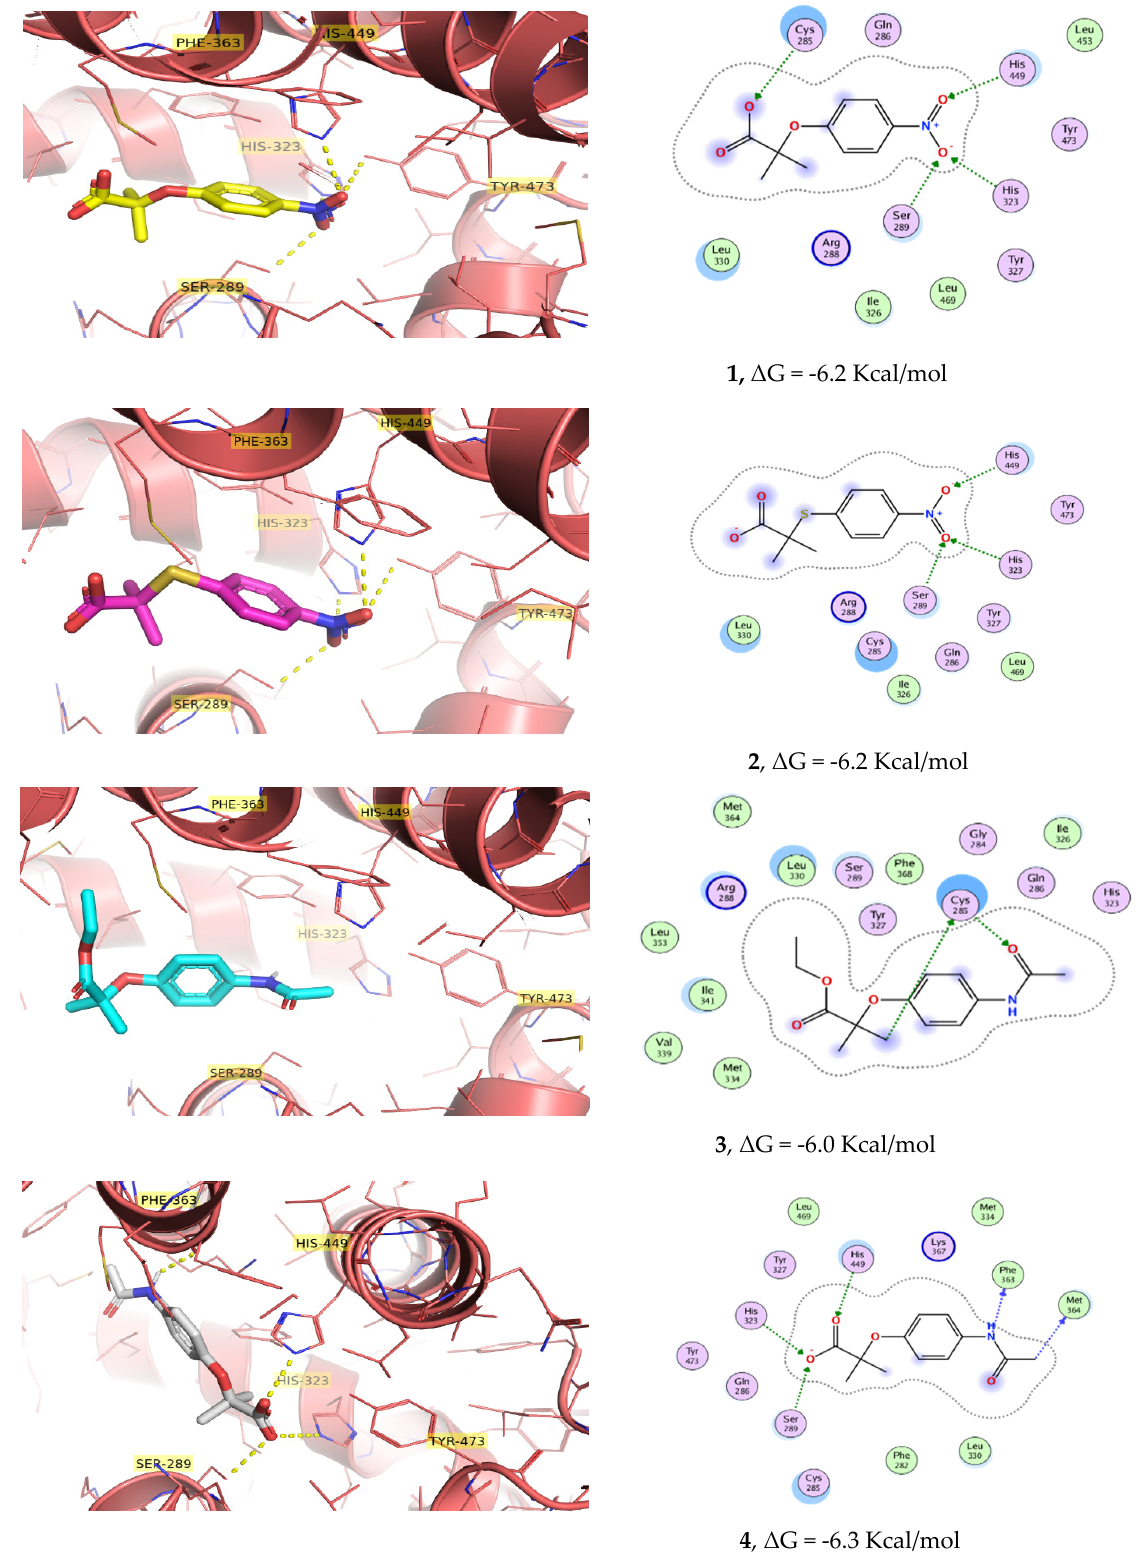
Figure 6. Docked poses of 1 (carbon atoms colored yellow), 2 (carbon atoms colored magenta), 3 (carbon atoms colored cyan), and 4 (carbon atoms colored gray), and 2D diagram of interactions in the ligand-binding site of PPAR γ